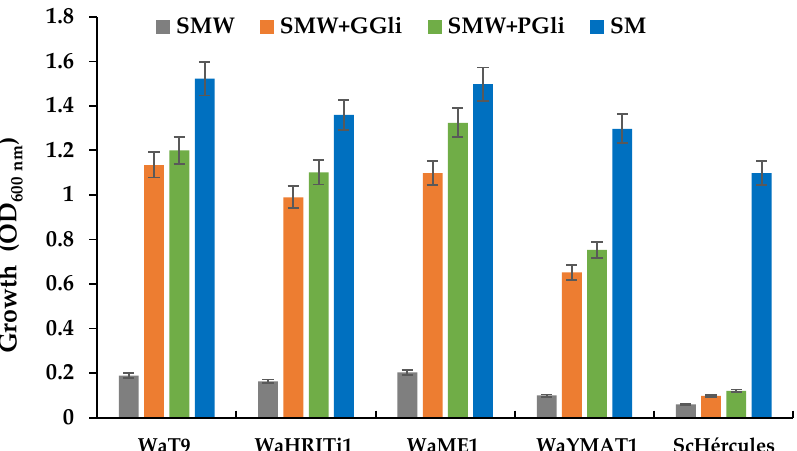
Figure 2. Growth of the Wickerhamomyces anomalus yeast in media with gliadin as the carbon and nitrogen sources. Representative W. anomalus strains WaT9, WaHRITi1, WaME1, and WaYMat1 were cultivated in microtiter plates for 4 days in the synthetic media without carbon and nitrogen sources (SMW, grey), SMW with wheat gliadins from gluten (SMW + GGli, orange) or pure wheat gliadins (SMW + PGli, green), and with carbon (glucose) and nitrogen (ammonium sulfate) sources (SM, blue). Baker´s yeast (ScHércules) was also cultivated in the same media. The bars represent the average OD 600 ± standard deviation of three independent experiments.